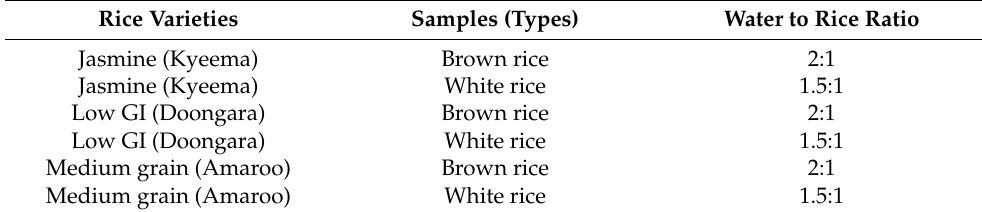
Table 1. Selected Australian rice